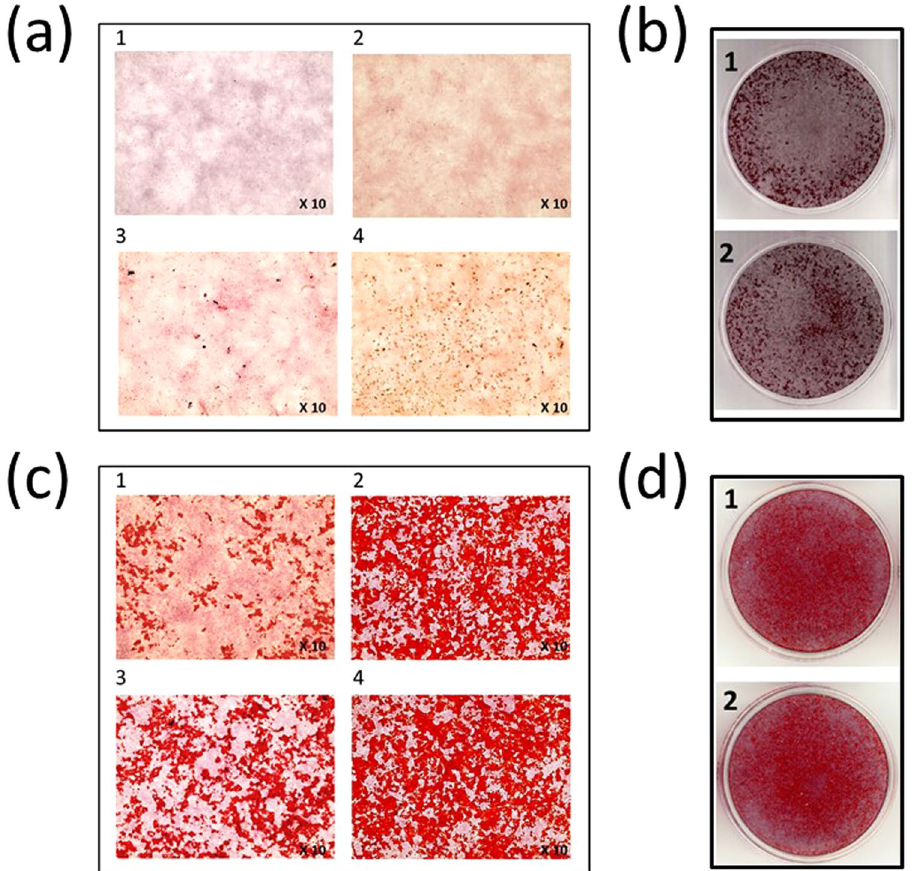
Figure 5. In vitro mineralization assay. MC3T3-E1 (MC) cells were cultured and stained Alizarin Red S (ARS). Upper panel. MC cells at day 11 ( a -1) and 14 ( a -2) and those treated with LRR2-3 at the same time points ( a -3 and a-4). ( b ) Scanned cultures at day 28 ( b -1: MC cells, b -2 MC cells treated with LRR2-3). Lower panel. MC cells treated with BMP-2 at day 11 (c-1) and 14 (c -2) and those treated with BMP-2 and LRR2-3 at the same time points ( c -3 and c -4). ( d ) Scanned cultures at day 14 ( d -1: BMP-2, d -2: BMP-2 and